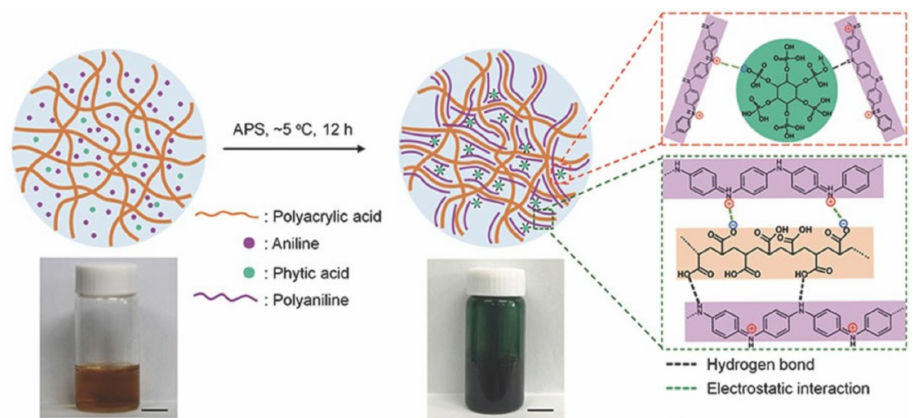
Figure 44. Diagram showing the synthesis of a ternary polymer composite and the corresponding interactions between PANI chains with PAA and phytic acid (scale bar = 1 cm). Reproduced from [205] with permission from John Wiley and Sons.